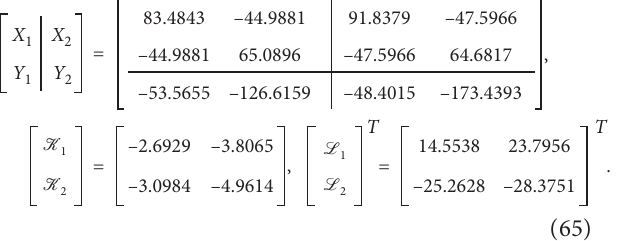
( t ) with estimation 􏽢 x 1